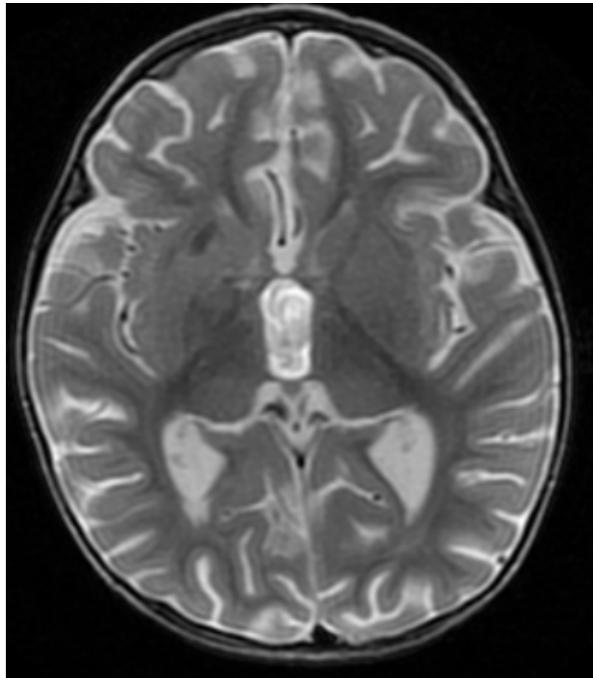
Figure 3: Contrast-enhanced brain magnetic resonance imaging showed meningeal enhancement, a reduced measures of the space- occupying lesion in the subcortical white matter, abnormal enhan- cement of basal cisterns and decreased diameter of the focalised lesion of the right internal capsule